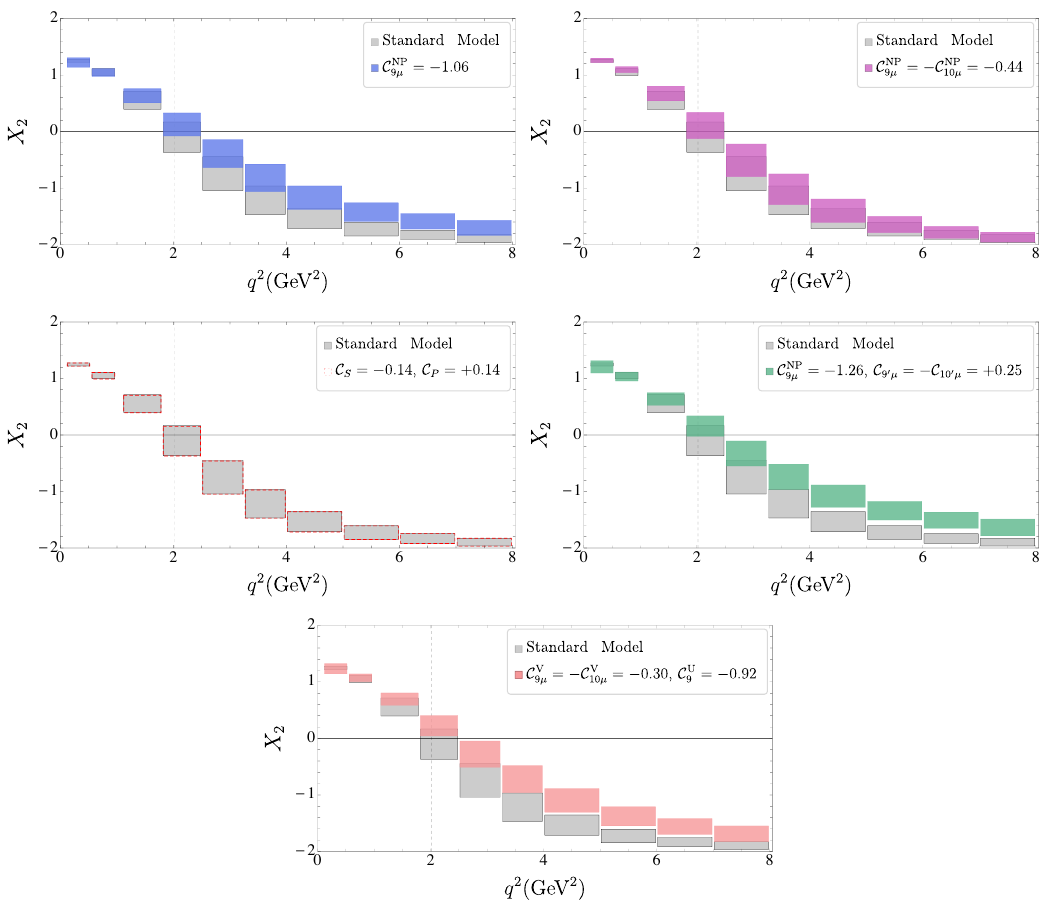
Figure 8 . SM and NP predictions for X 2 binned in q 2